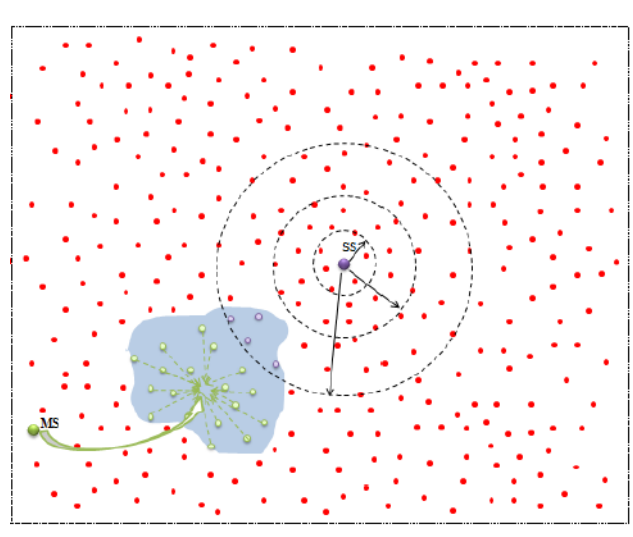
Figure 7. SS outside the event (MSmov).